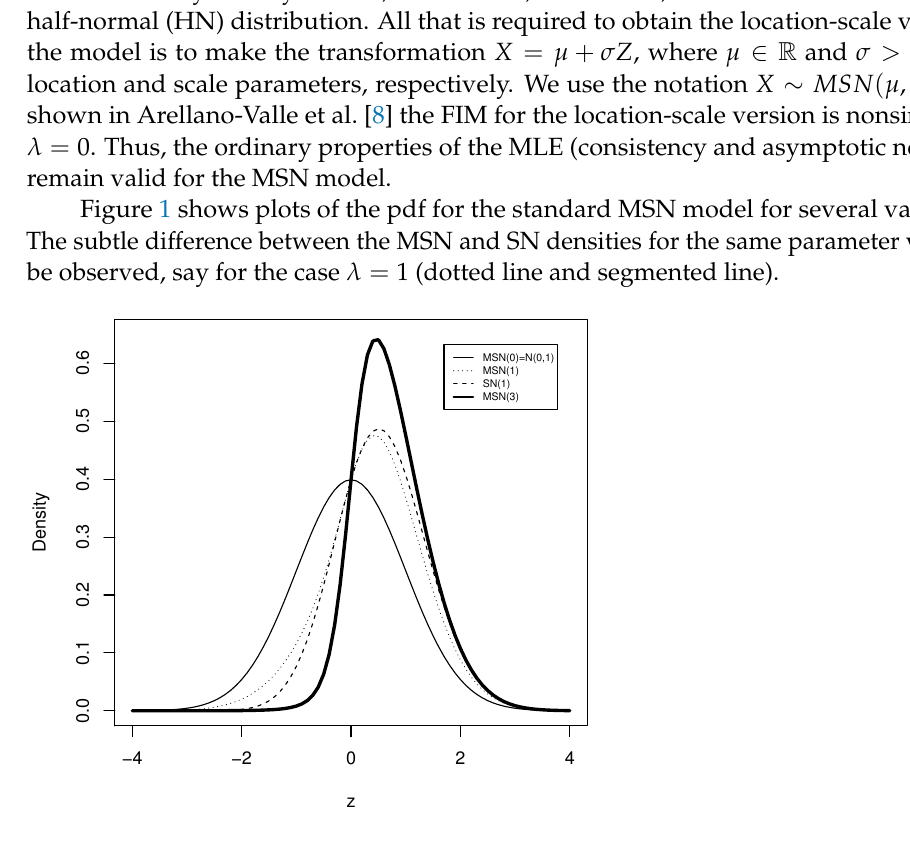
Figure 1. Plots of the MSN ( λ ) model for different values of λ : MSN ( 0 ) (solid line), MSN ( 1 ) (dotted line), SN ( 1 ) (dashed line), and MSN ( 3 ) (thick solid line)